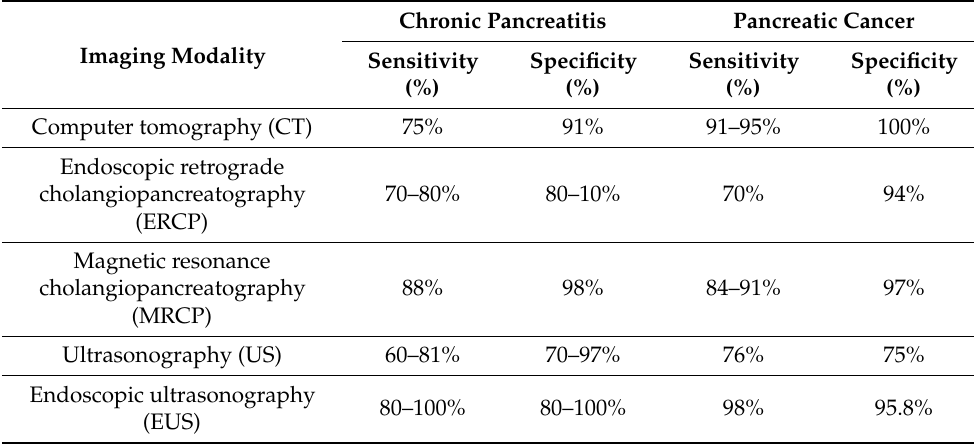
Table 1. Existing imaging techniques for the diagnosis of pancreatic disorders. Chronic Imaging Modality